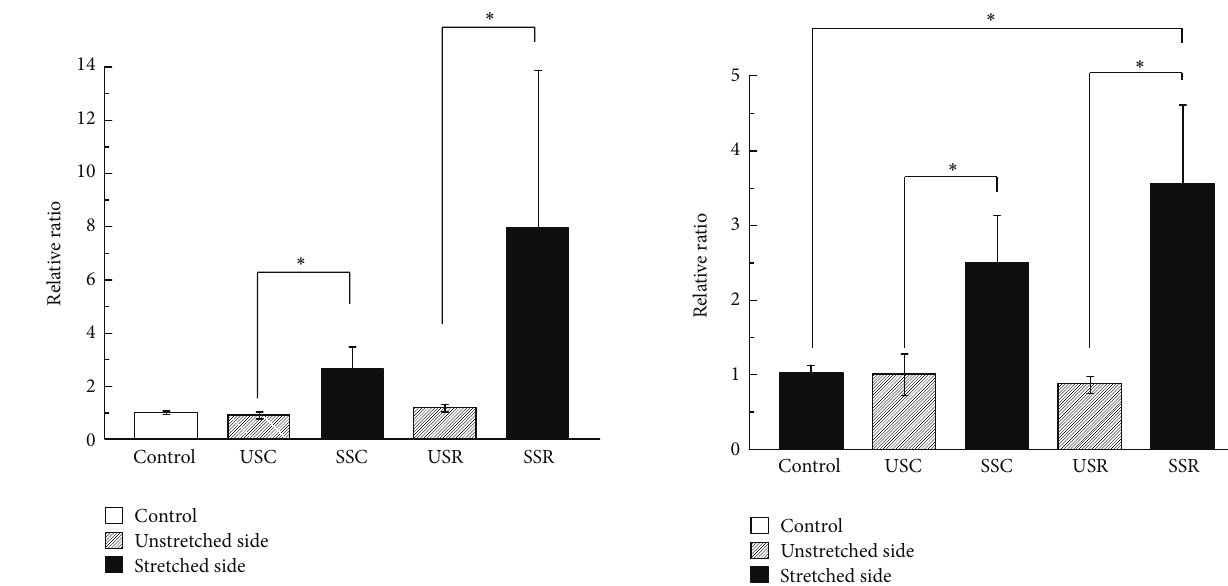
Figure 3: MyHC mRNA expression. Relative ratio of MyHC mRNA expression induced under different stretching conditions (mean ± SE). The open bar shows the control group; shaded bars denote the unstretched side of continuous stretching and repetitive stretching; andfilledbarsdenotethestretchedsideofcontinuousstretchingand repetitive stretching. Significant differences were displayed ( ∗ 𝑃 < 0.05